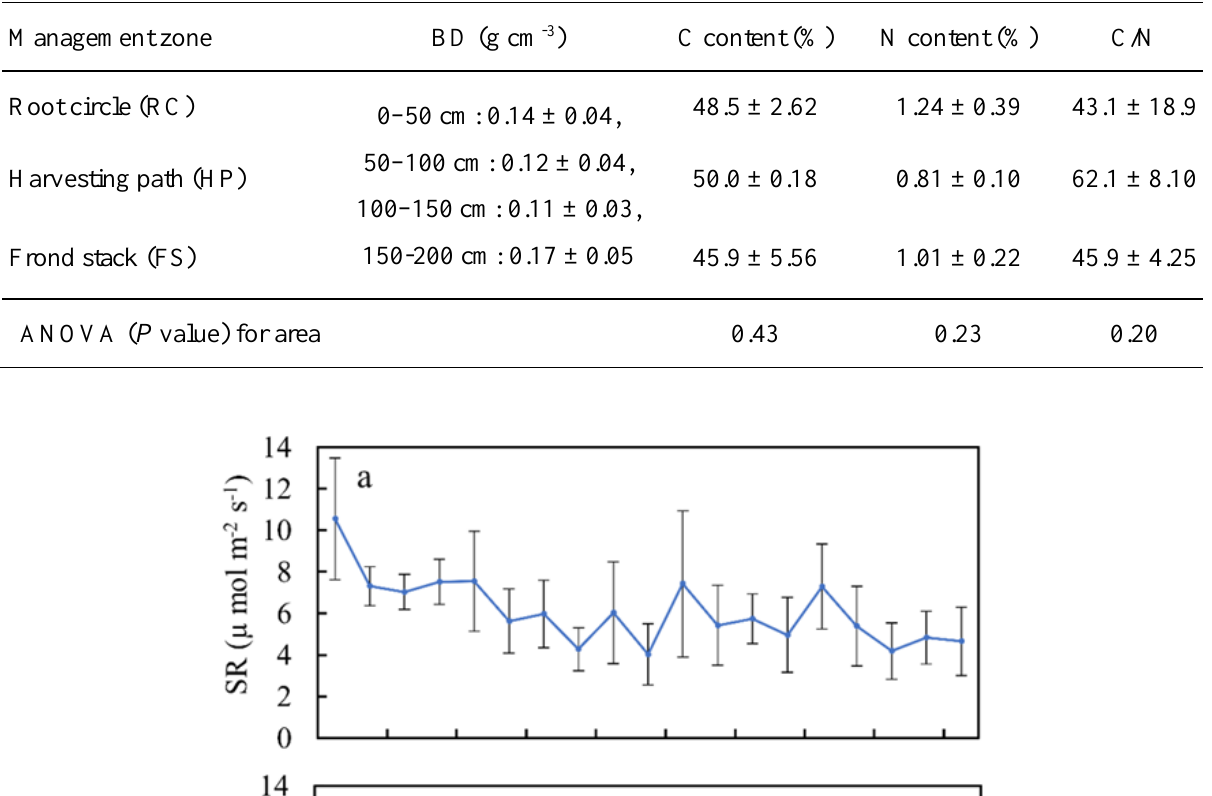
Table 1. Main characteristics of peat (mean ± SD, n = 3): bulk density (BD), carbon (C) and nitrogen (N).